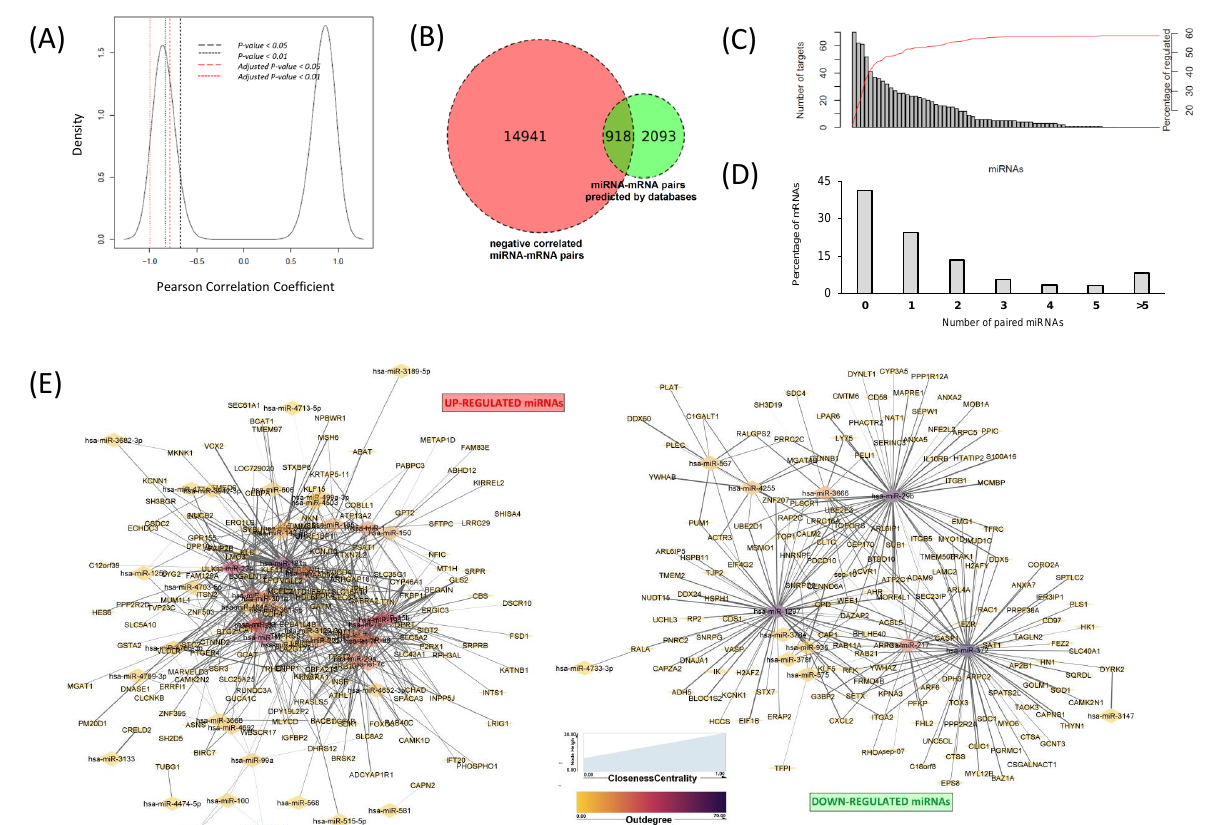
Figure 2. MiRNA-mRNA interactions predicted by miRComb in IPMN. ( A ) Pearson Correlation plot showing density of miRNA-mRNA pairs. Only pairs showing negative correlation and adjusted p -value < 0.05 were selected. ( B ) Venn diagram. Red: number of miRNA-mRNA pairs with negatively correlated expression in IPMN and healthy pancreatic tissues (adj. p -value < 0.05). Green: all the theoretical miRNA-mRNA pairs reported by at least 1 of the following miRNA target prediction databases: targetScan_v7.1_17, miRSVR_aug10_17, and miRDB_v5.0_21. Intersection: miRNA-mRNA pairs that fulfil both conditions. ( C ) Barplot representing the number of mRNAs targeted per each miRNA (each bar represents a miRNA). MiRNA-mRNA interactions with pval-corrected < 0.05 and predicted at least 1 time on the studied databases. Red line (and right axis) represents the percentage of deregulated mRNAs that are cumulatively targeted by the miRNAs. ( D ) Barplot representing the number of miRNAs targeting each mRNA. ( E ) Network analysis of miRNA-mRNA couples reported in IPMN. Directed networks of miRNAs and mRNAs are represented. Circle size indicates Closeness to centrality; circle colours indicate outdegree (Min.-yellow, max.–dark purple). We can see two networks corresponding to upregulated miRNAs with its downregulated pairs and vice versa. Table 1. Top 45 miRNA-mRNA pairs in IPMN (sorted by adjusted p -value). Each miRNA-mRNA pair has pval-corrected < 0.05 and appear at least 1 times in the following databases: